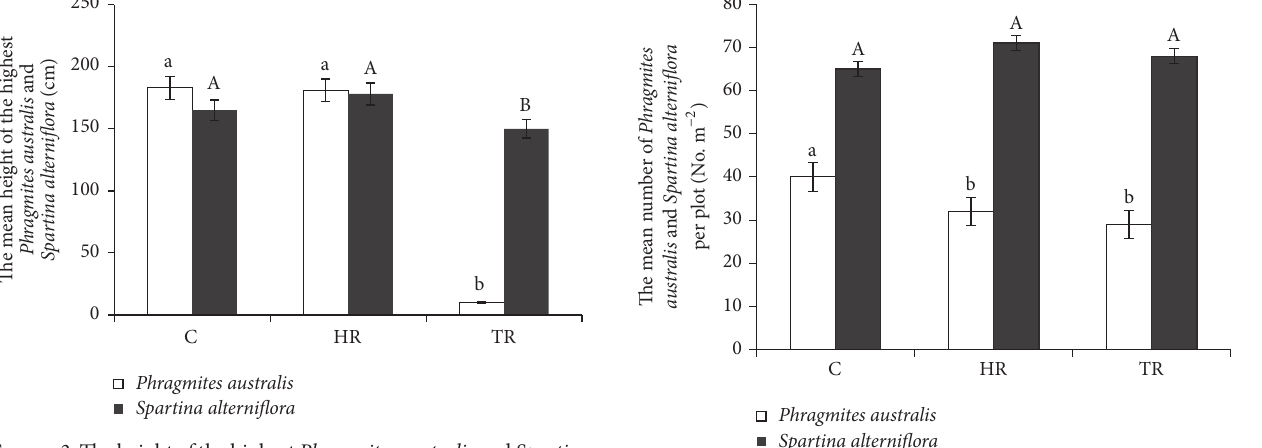
Figure3:Theheightofthehighest Phragmitesaustralis and Spartina alterniflora (mean ± SE)indifferentmowingtreatments:control(C), HR(half-removal),andTR(total-removal).Differentlettersindicate a significant difference ( 𝑃 < 0.05 ) among treatments.